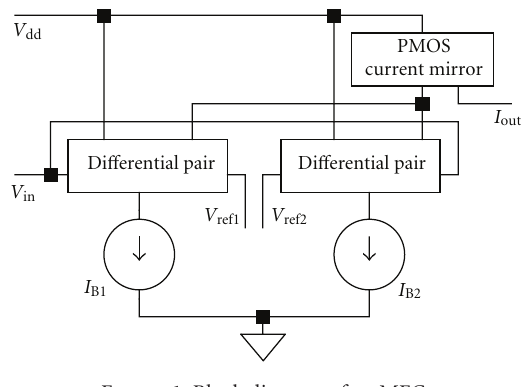
Figure 1: Block diagram of an MFC.